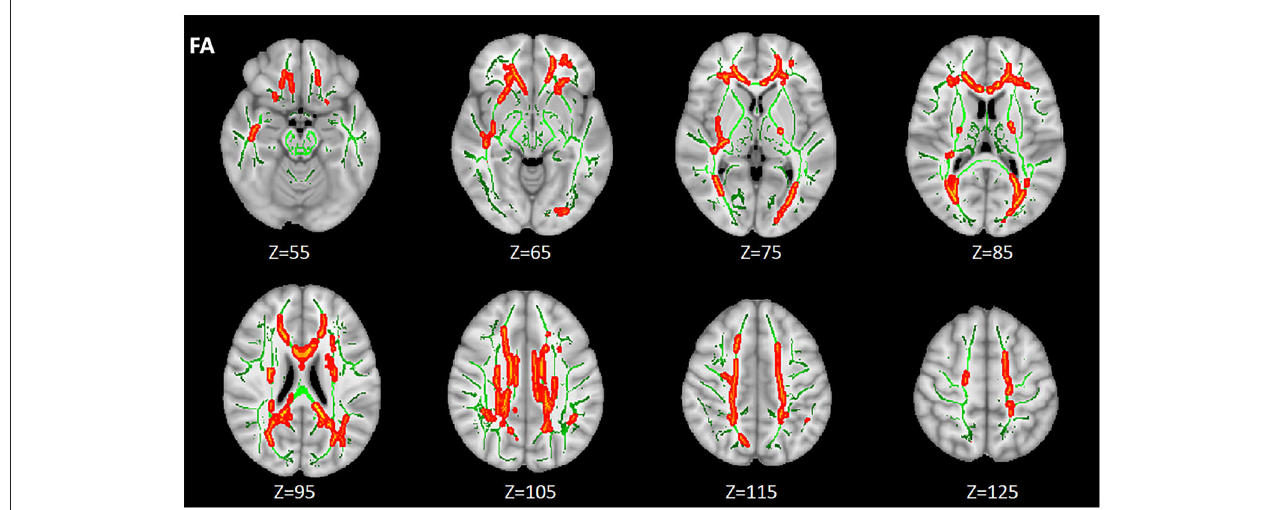
FIGURE 3 | The differences of FA between the HIV + /syphilis– group and the HIV + /syphilis + group. Areas in red represent brain regions with significant lower FA in the HIV + /Syphilis + group compared with the HIV + /Syphilis– group (FWE-corrected p < 0.01). Green represents mean white matter skeleton of all subjects. The number below each brain image indicates the Z coordinate in the MNI